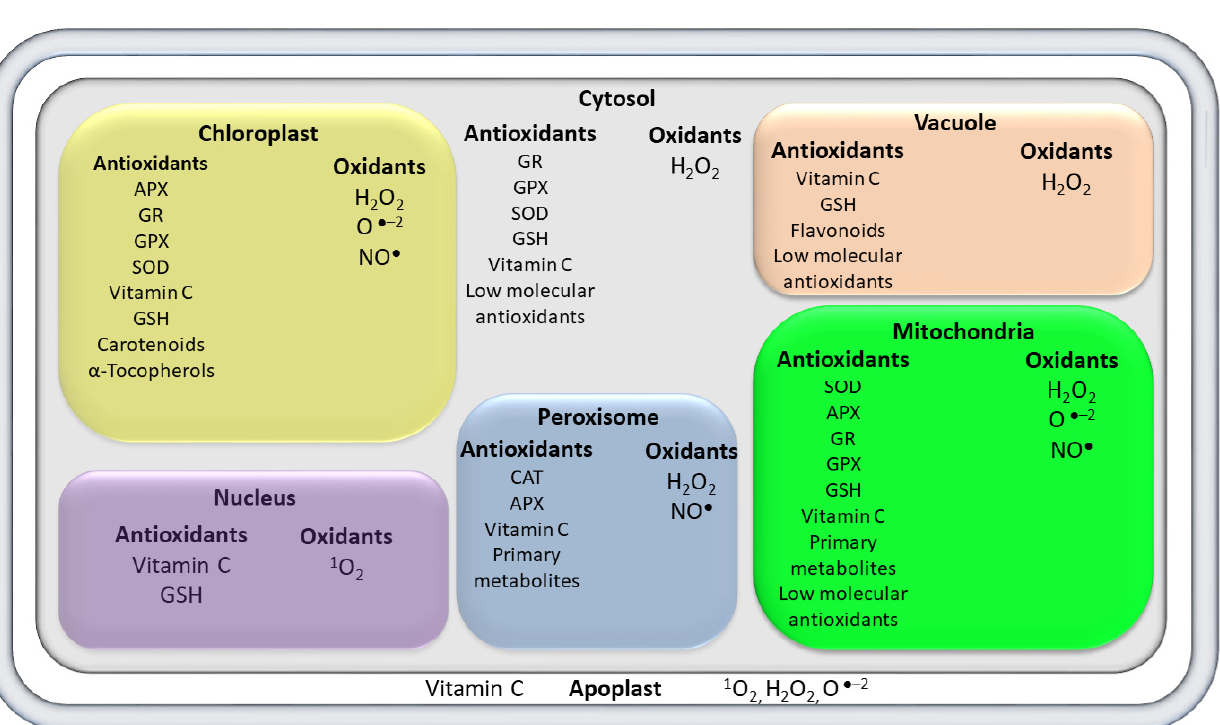
Reaction with ROS to Enzymatic Scavenging Metabolic Enhance Stress System Antioxidants Tolerance